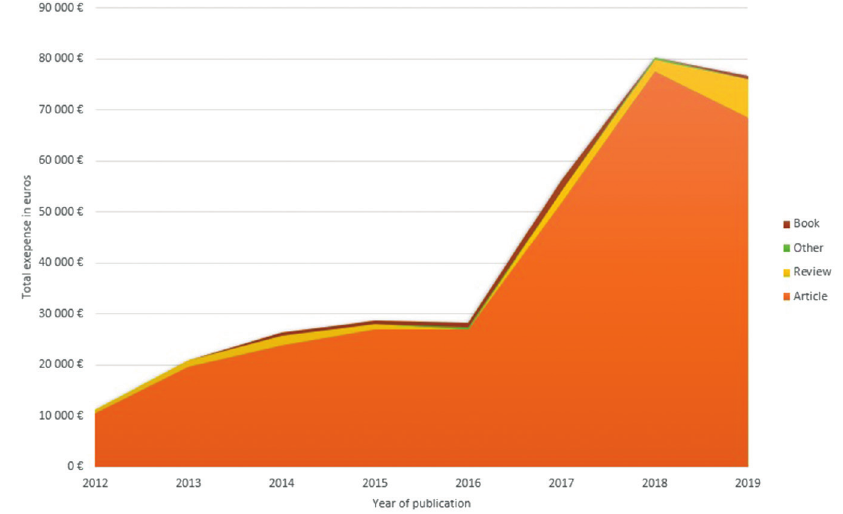
Fig. 8: Volume of real expenses by year and type of publication